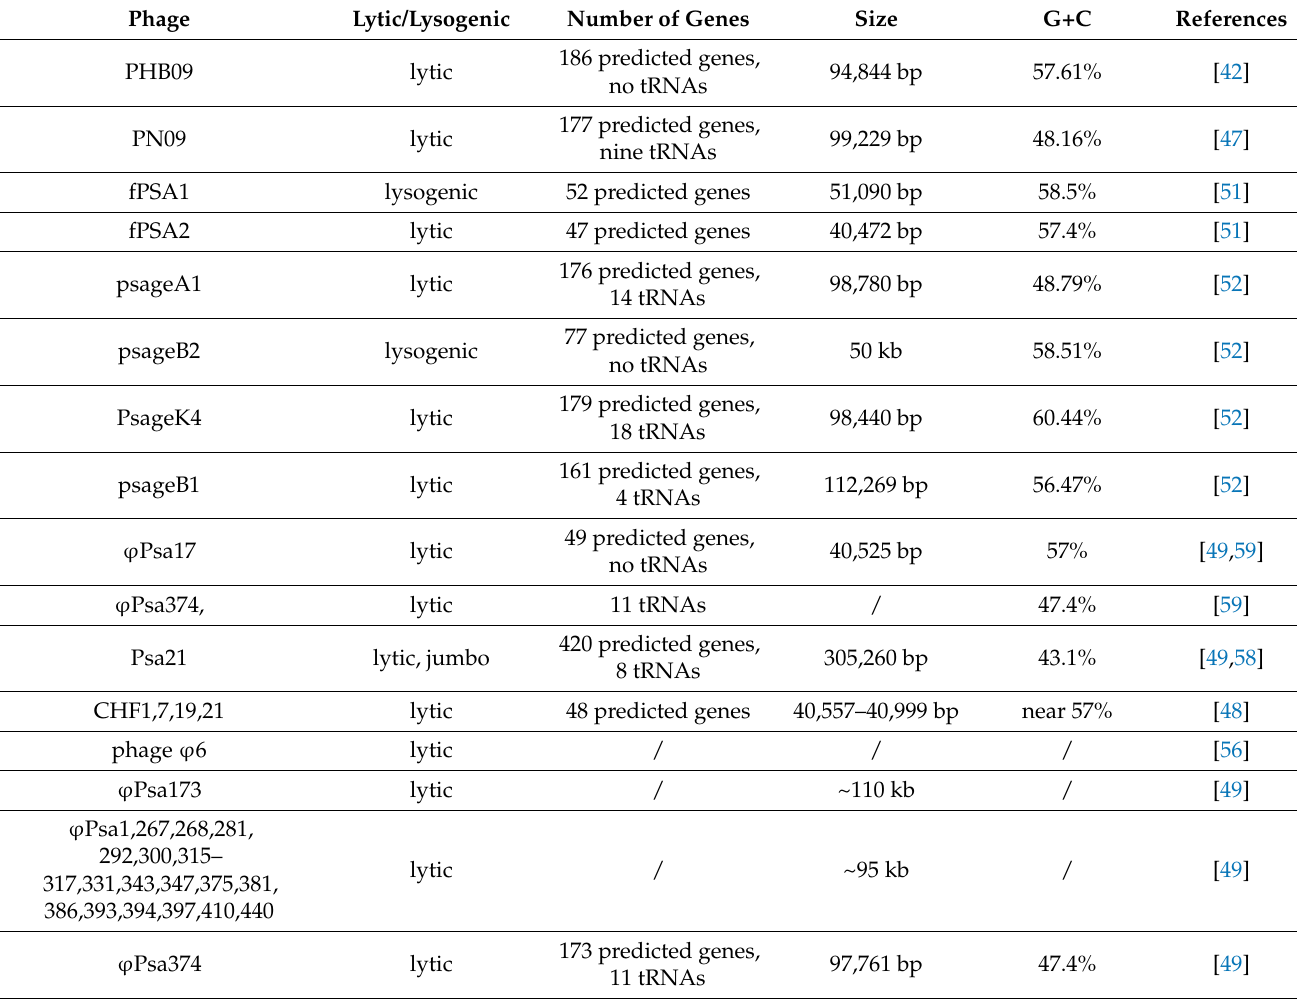
Table 3. Genomic characterization of the Psa phages from the currently available